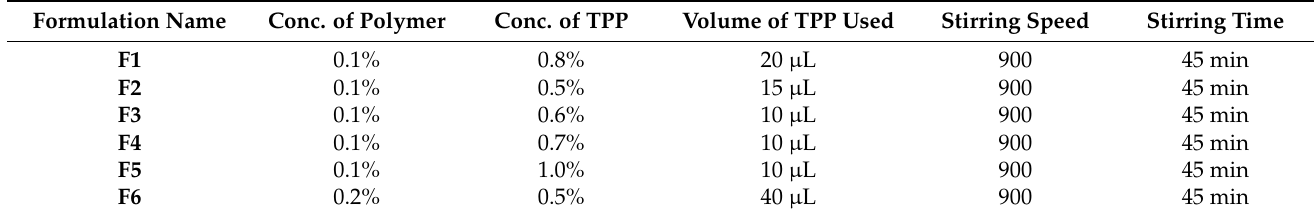
Table 1. Optimization parameters for development of blank nanoparticles